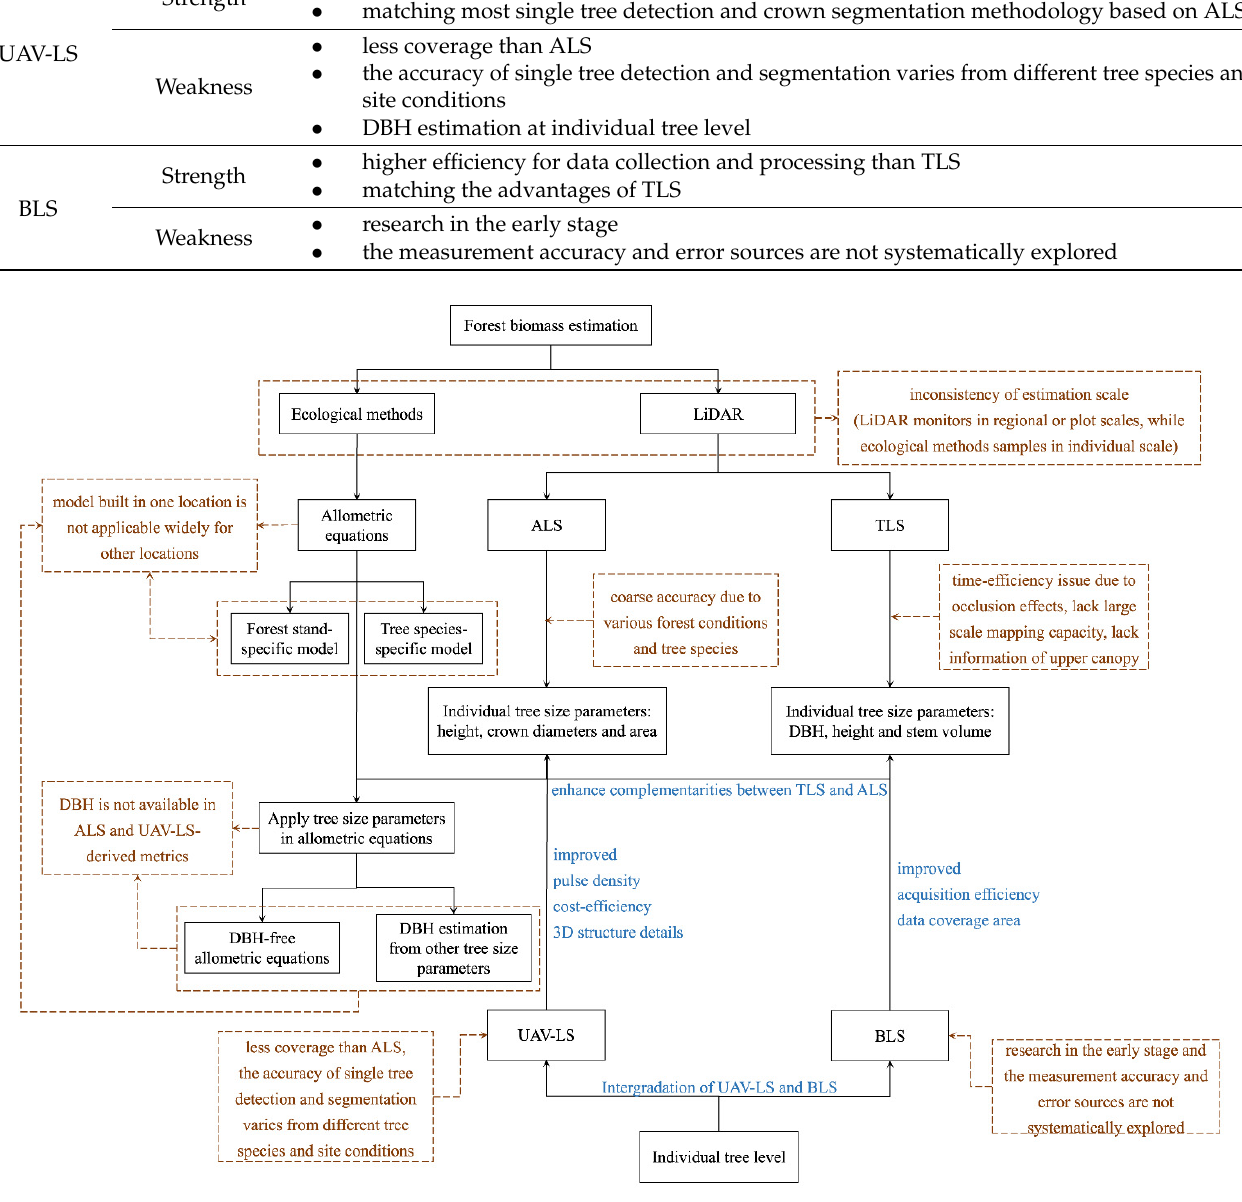
Figure 1. Challenges of current methodology for applying remote sensing to forest biomass estimation at the individual tree scale.